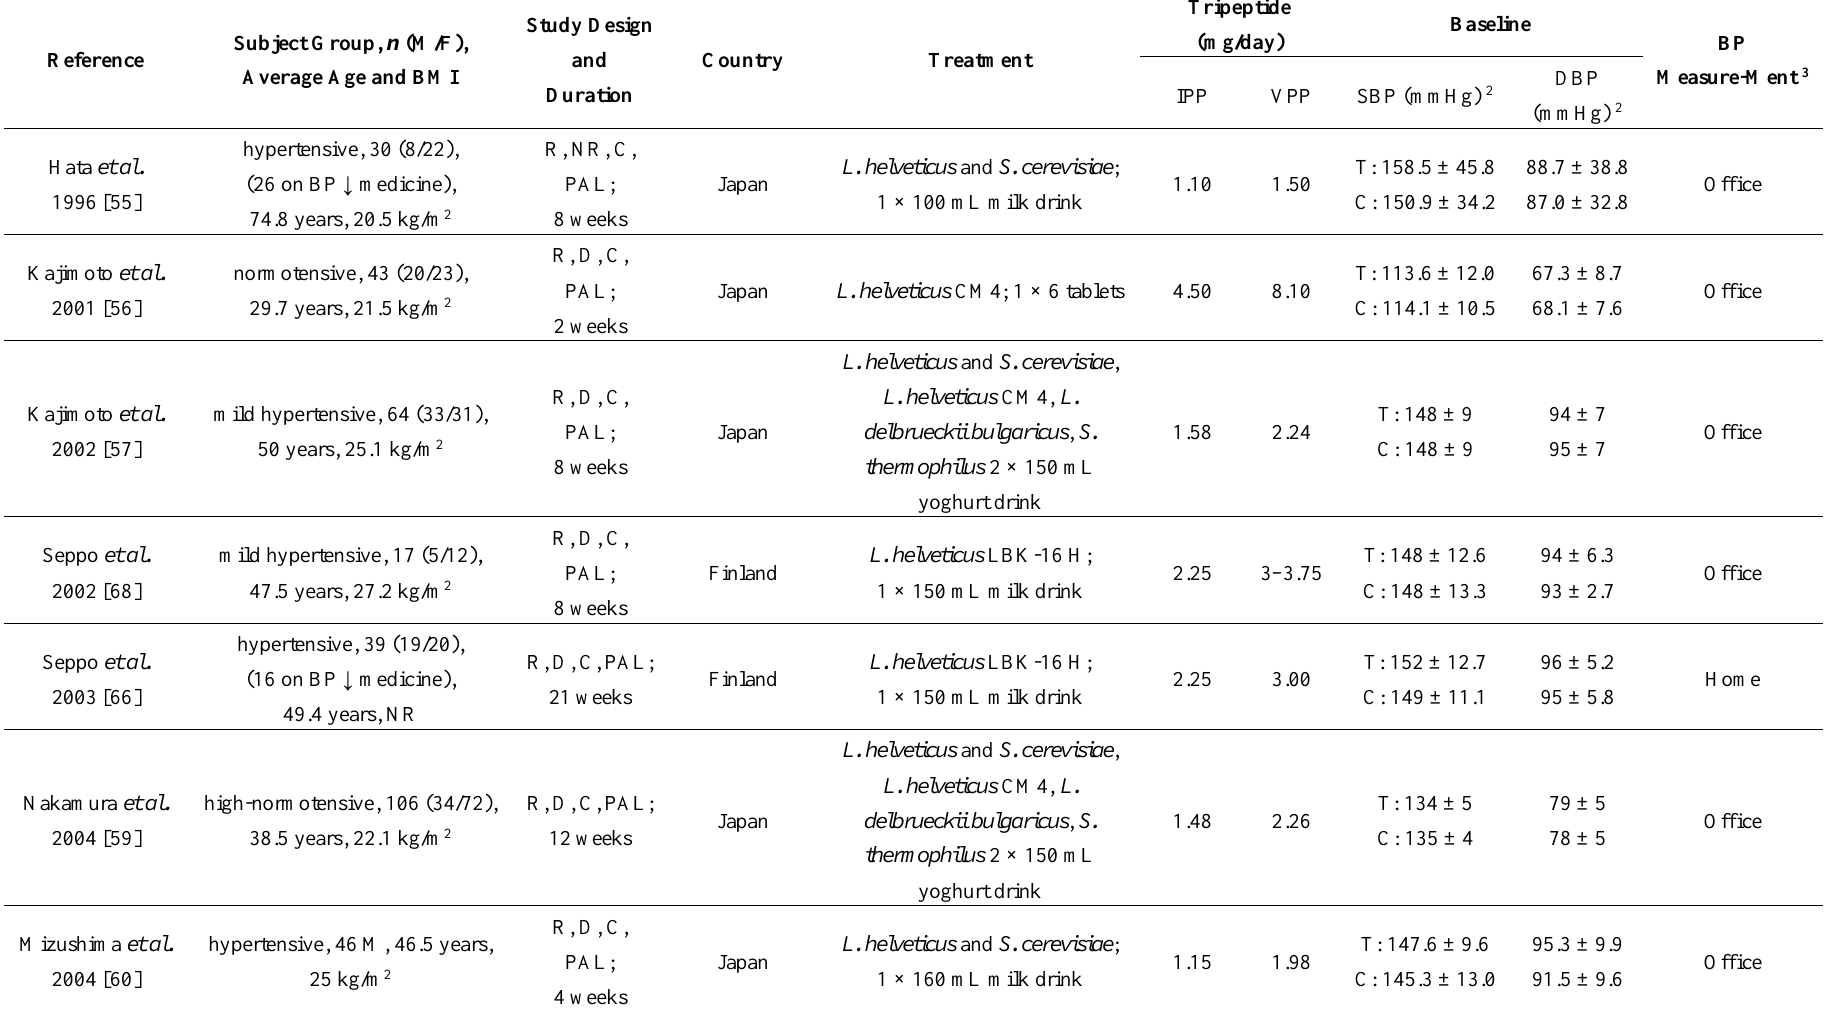
Table 1. Trial characteristics of studies included in the meta analysis 1